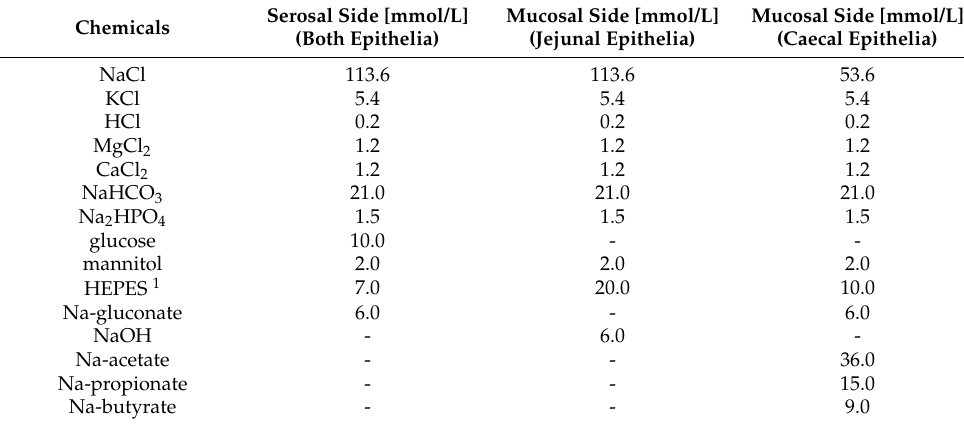
Table 2. Protocol for the preparation of buffer solutions for the Ussing chamber procedure (concen- tration in